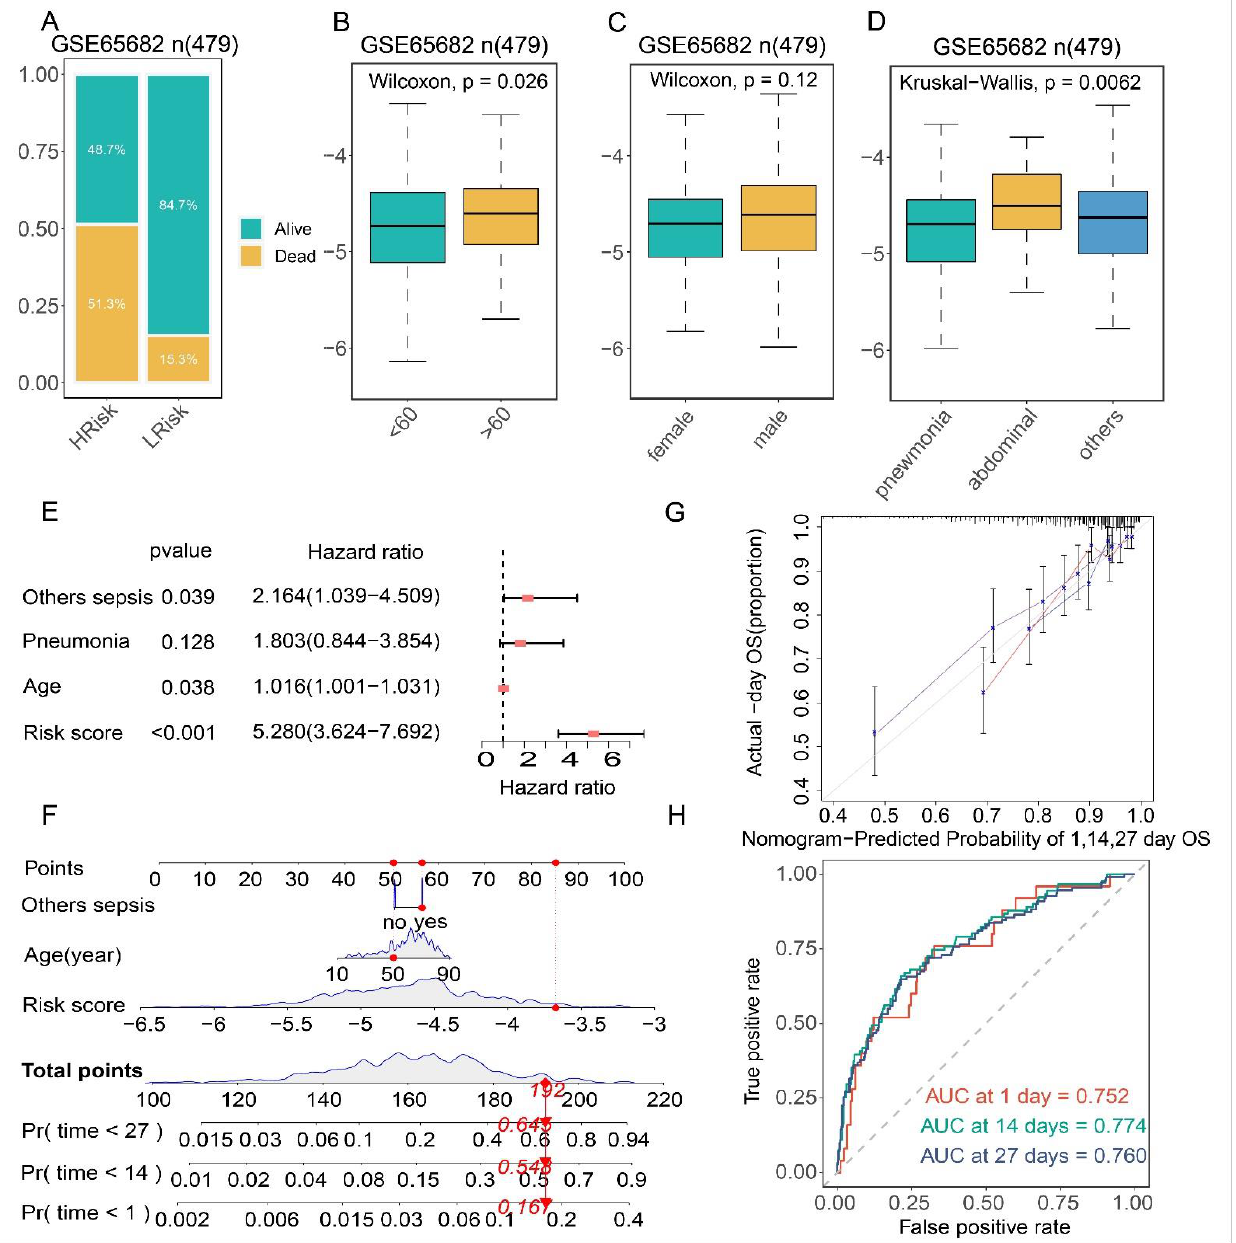
Figure 3. Clinical correlations of risk score and development of the nomogram in the GSE65682 dataset. ( A – D ) Relationships between the risk score and clinicopathological characteristics (age, gender, Infection site). ( E ) Multivariate analyses revealed the risk score was an independent prog- nostic factor for sepsis patients. ( F ) Nomogram for predicting the 1-, 14-, and 27-days OS of sepsis patients. ( G ) Calibration curves of the nomogram for OS prediction at 1-, 14-, and 27-days. ( H ) ROC curves predicting 1-, 14-and 27- days OS. Draw a line straight upward to the point ’ s axis to give a score of each variable, and finally add the score of the three variables (sepsis infectious site, age, and risk score) to obtain the total score. The probability of survival is obtained by drawing a vertical line down the total score. Others sepsis = Sepsis, except for pneumonia and abdominal sepsis; Age = age in years; Risk score = risk score calculated by 14-FAG model; Pr = survival probability.